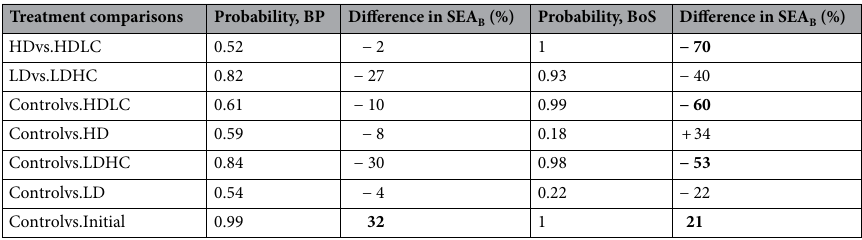
Table 3. Pairwise comparisons of the Bayesian standard ellipses area (SEA B ) between the treatments testing effects of diatom and cyanobacteria addition to the control sediment for each basin (BP vs. BoS). The probability of the different SEA B values (fold change, increase/decrease) was considered significant when > 0.95 (% Difference is shown in bold).